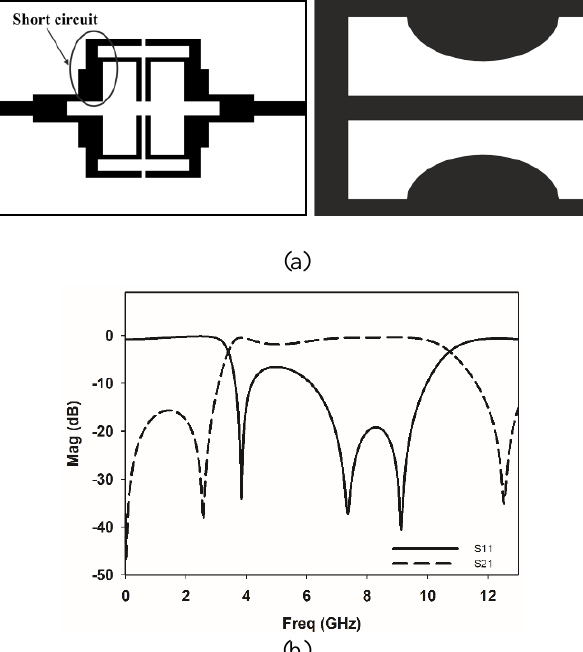
FIGURE 2. Geometry and simulation of the first filter design (a) Top and bottom view, (b) S-parameters.